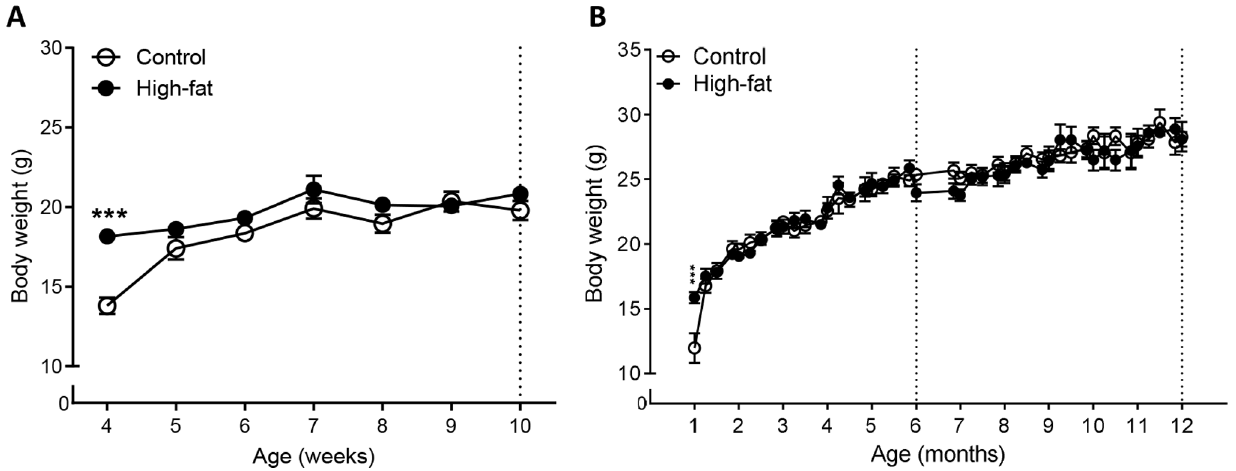
Figure 2. A high-fat diet during pregnancy and lactation transiently increases bodyweight in female 3xTgAD offspring. In separate groups of mice bodyweight was measured weekly after weaning between 4–10 weeks of age (approximately 2 months of age) (A) and 1–12 months (B) in female 3xTgAD offspring mice from either control or high-fat fed dams. Dashed line indicates the age at which behaviour was assessed (data are presented in Figures 3 and 4). Data are mean 6 SEM for n =5 per group. *** P , 0.001 versus control fed mice.